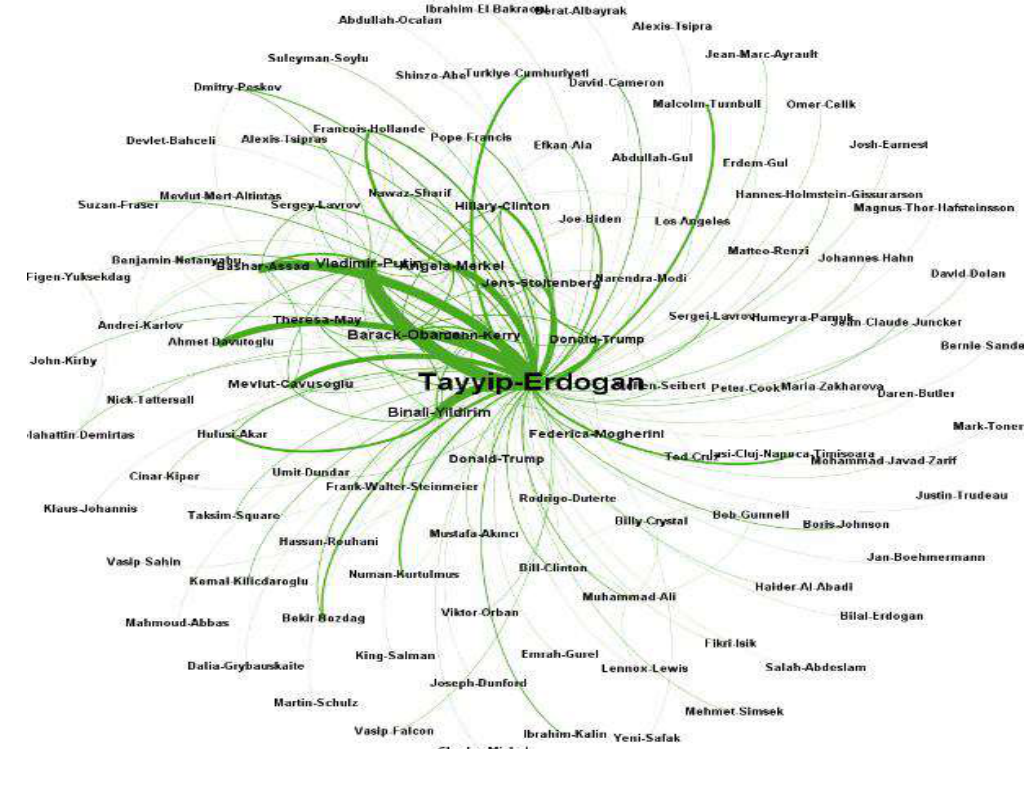
Figure 3: 2016 Network (Source: Authors ‟ depiction)